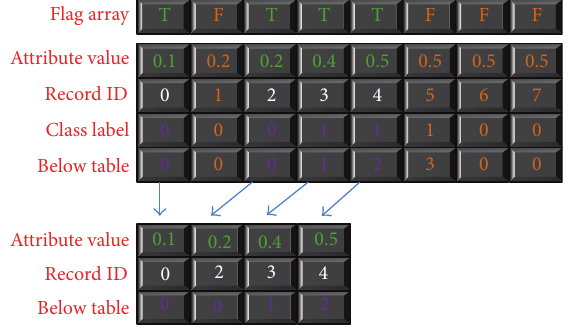
Figure 10: Example of Reduce